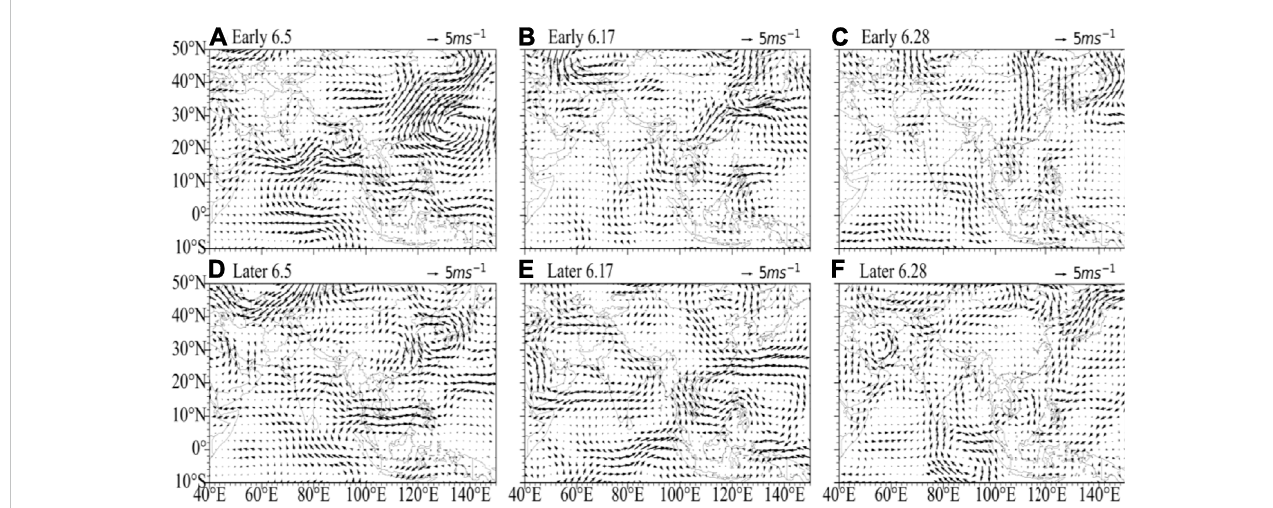
FIGURE 6 850 hPawind fi eld(unit:m/s)anomaliesintheearlyyears (A) , (B) , (C) andlateyears (D) , (E) , (F) oftheYangtze-HuaiheRiver (A) , (D) :June5 th ; (B) , (E) :June 17 th ; (C) , (F) : June 28th).